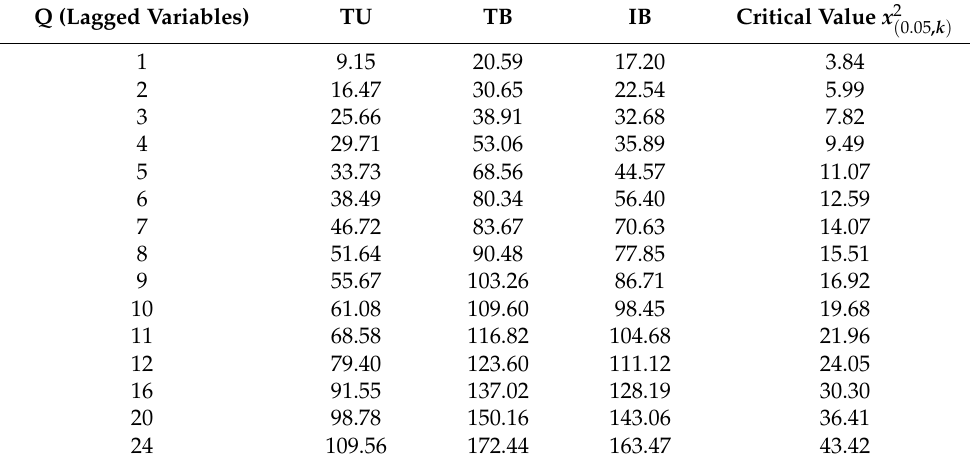
Table 3. Results of EGARCH(q) examination of 3